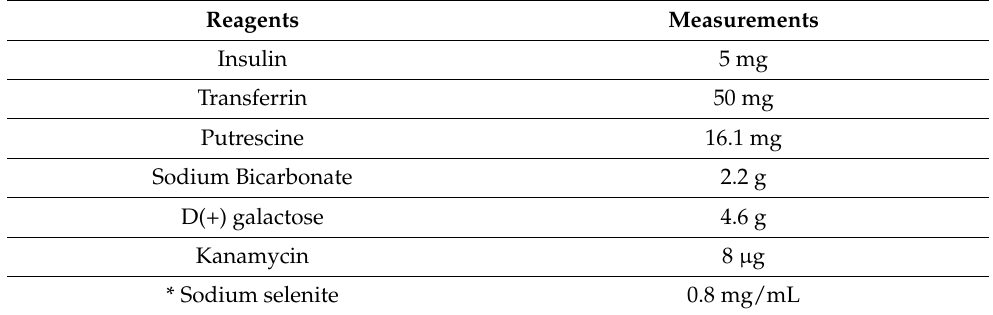
Figure 1. Ectoderm selection was performed by exposing hiPS to SB431542 (SB) and dorsomorphin (DM) to instruct ectoderm formation preferentially, while inhibiting endodermal and mesodermal commitment. Once specified, a stock of hiPS ‐ derived OLPs was created for all pre ‐ flight and post flight experiments in order to keep passage number low (18 passages maximum). Details of the procedure described here have been published [2]. This medium was designed to induce and maintain the OLP ‐ phenotype. OLPs flew to space in OSM with N2 + B27. (Figure modified from [3]). The composition of the basal “OSM” (oligodendrocyte specification medium) is shown in Table 1 . Table 1. Preparation of OSM basal.